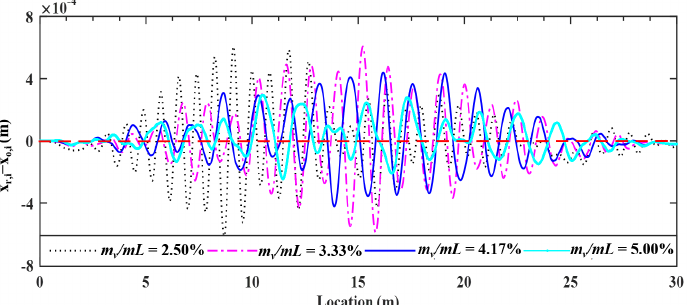
Figure 13. Deviations of surface profile identified for different vehicle masses.